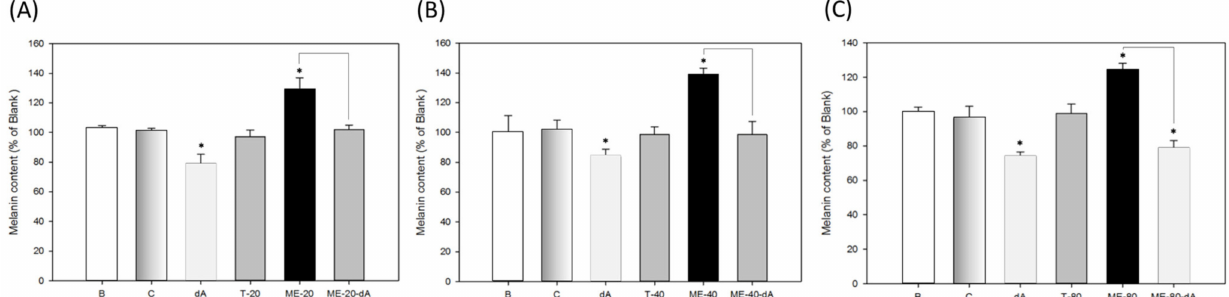
Figure 7. Melanin contents of B16-F10 cells treated with microemulsions: ( A ) ME-20-dA; ( B ) ME-40-dA; ( C ) ME-80-dA. B: blank group (medium only); C: control group (0.1% dimethyl sulfoxide as the solvent for dA); dA: deoxyArbutin (20 µ M); T-20: Tween 20 (2000 µ M); T-40: Tween 40 (1000 µ M); T-80: Tween 80 (2000 µ M); ME-20: Tween 20-based microemulsion (1 × 10 − 4 w / w ); ME-40: Tween 40-based microemulsion (1 × 10 − 4 w / w ); ME-80: Tween 80-based microemulsion (1 × 10 − 4 w / w ); ME-20-dA: Tween 20-based microemulsion encapsulating dA (1 × 10 − 4 w / w ); ME-40-dA: Tween 40-based microemulsion encapsulating dA (1 × 10 − 4 w / w ); ME-80-dA: Tween 80-based microemulsion encapsulating dA (1 × 10 − 4 w / w ). Data are presented as means ± SE ( n = 3); * indicates a p value of less than 0.05 when compared with the